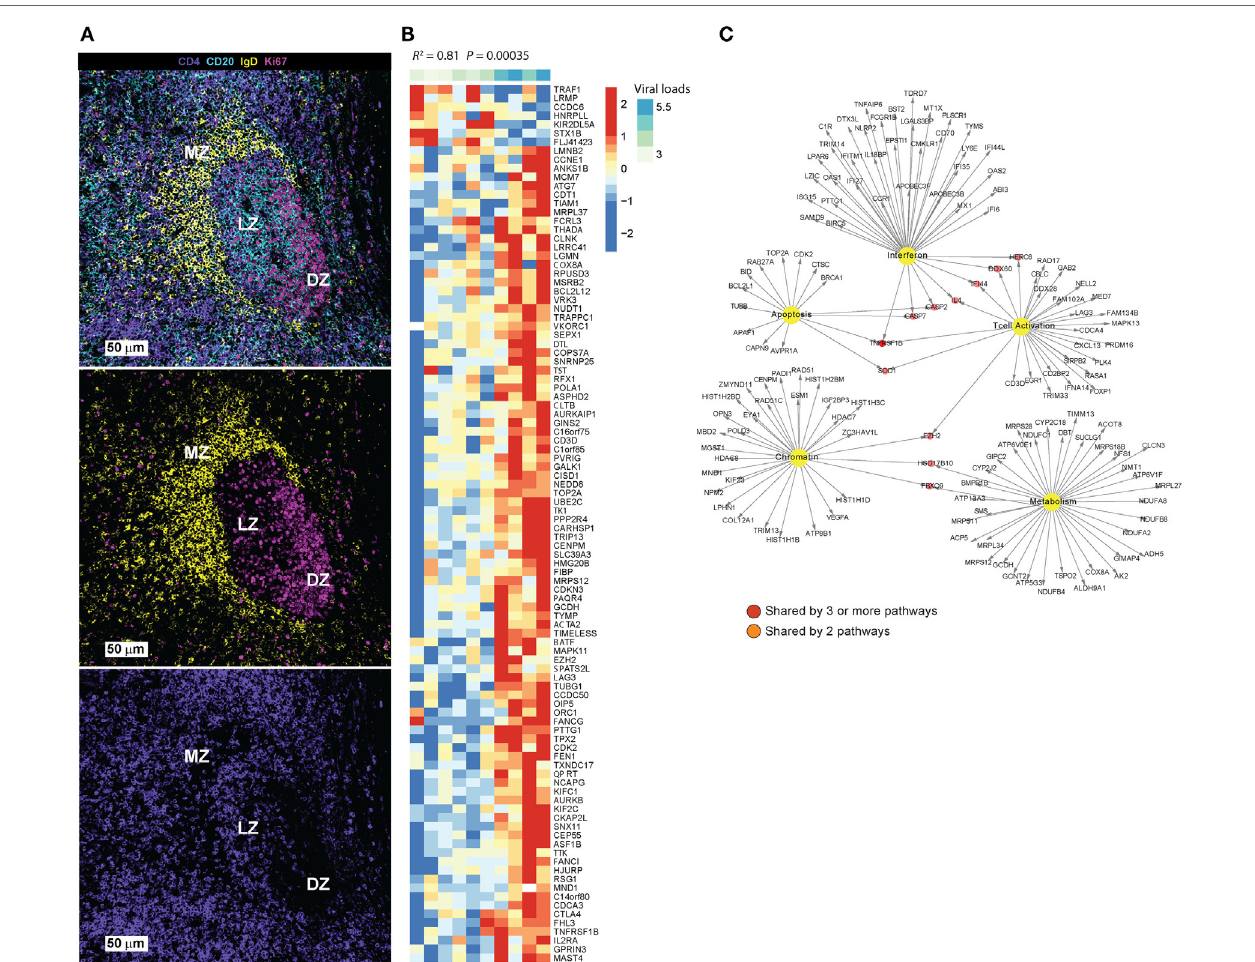
FIGURE 1 | (A) Main areas of a tonsillar follicle defined by IgD (yellow), CD20 (cyan), and Ki67 (magenta) are shown: marginal zone (IgD hl CD20 dim ), germinal center light zone (IgD neg sCD20 hi Ki67 hi/lo ) and dark zone (IgD neg PCD20 dim Ki67 hi ). The distribution of CD4 T cells (purple) is shown in the lower image. (B) Differential gene expression analysis was performed using Limma model by comparing sorted TFH cells (CXCRS high ) vs. Non-TFH (CXCR5 low ) from eight HIV- donors in LNs. A corrected p -value cutoff of 0.05 (BH method) was used to select significant upregulated genes (731 genes) in CXCR5 high vs. CXCR5 low TFH cells. Linear regression model to correlate these genes to viral load in a cohort of HIV viremic subjects (10 viremic subjects) was performed in R. Heatmap shows the log 2 normalized expression of each gene transformed to z -score where the average expression of each gene was subtracted and divided by its SD across samples. Genes that correlated significantly to viral load ( p -value < 0.05) were shown on the heatmap. (C) Pathways enrichment analysis using genes in panel (B) and a compiled set of pathways from MsigDB C2 collection (http://software.broadinstitute.org/gsea/msigdb/collections.jsp#C2) and pathways from Chaussabel et al. (16) was performed. A FDR cutoff of 0.05 was used to selected pathways significantly correlated to viral loads. Interferon, metabolism, T cell activation and differentiation, apoptosis, and chromatin regulators were enriched. Cytoscape was used to infer gene-interacting networks of the leading genes of these pathways. Yellow nodes represent pathways name, red nodes represent genes shared by more than three pathways, orange nodes represent genes shared by two pathways, and white nodes represent genes specific to each pathway.